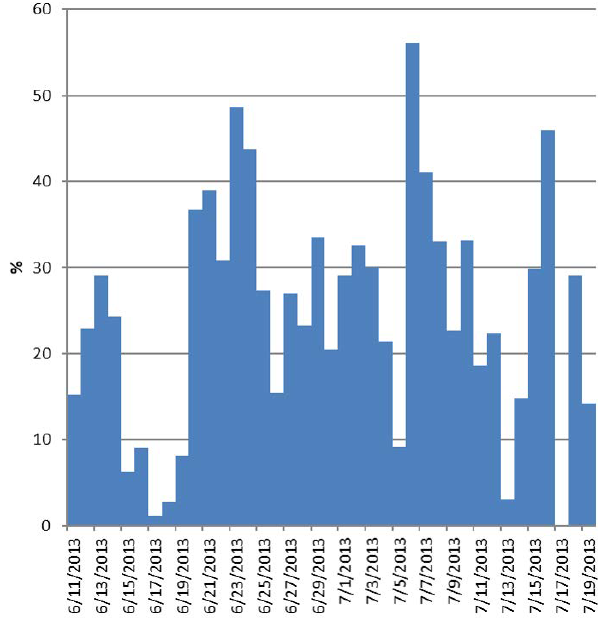
Figure 5. FMS (figure of merits in space) (%) from 11 June to 19 July in 2013 during the SENEX